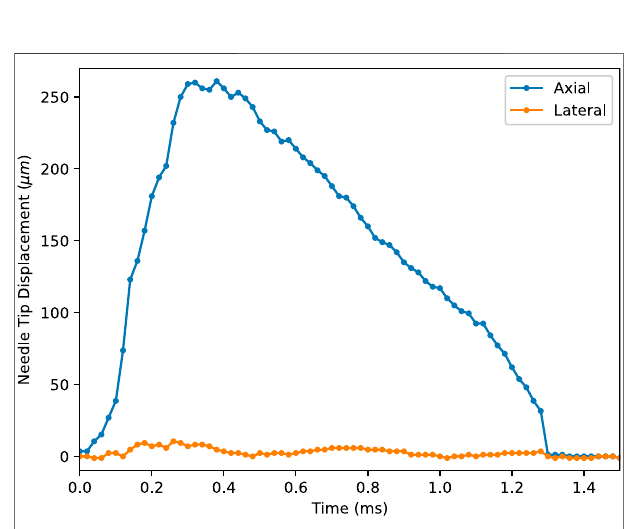
FIGURE 3 | The needle tip displacement in axial and later